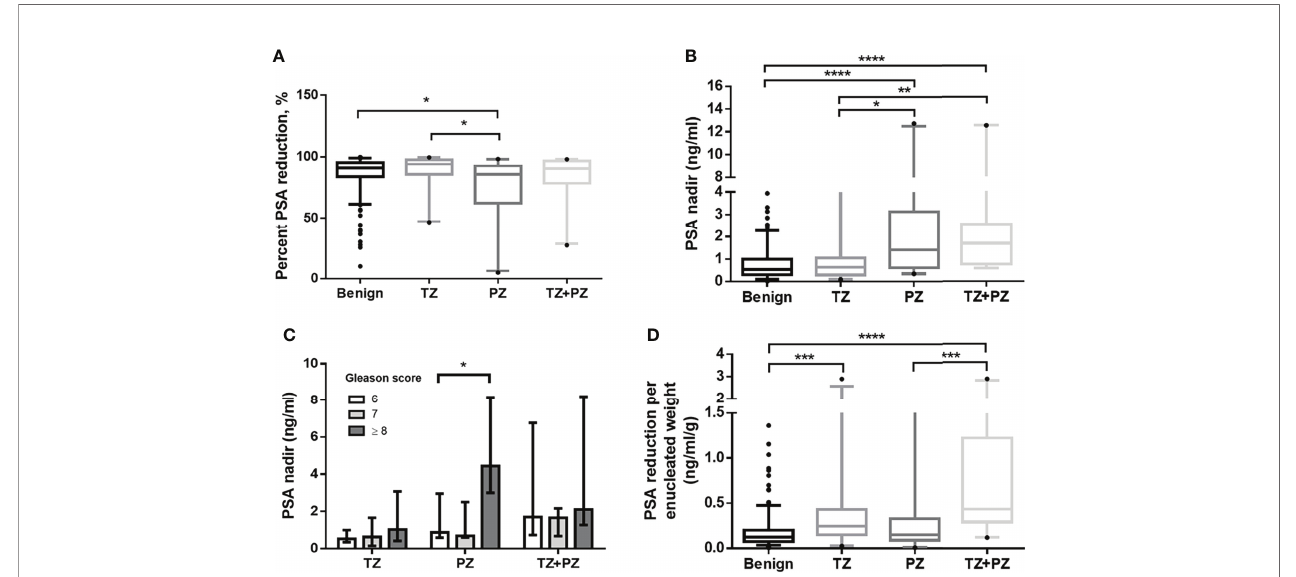
FIGURE 2 | Postoperative PSA parameters for men treated by transurethral prostate enucleation. (A) Percentage PSA reduction by patient groups (p = 0.004, Kruskal – Wallis test) (B) Nadir PSA values by patient groups (p < 0.001, Kruskal – Wallis test) (C) Nadir PSA values by the Gleason score in each cancer group (D) PSA reduction per enucleated prostate weight by patient groups (p < 0.001, Kruskal – Wallis test) PSA, prostate-speci fi c antigen; TZ, transition zone; PZ, peripheral zone *p < 0.05, **p < 0.01, ***p < 0.001, ****p < 0.0001, Mann – Whitney U test.